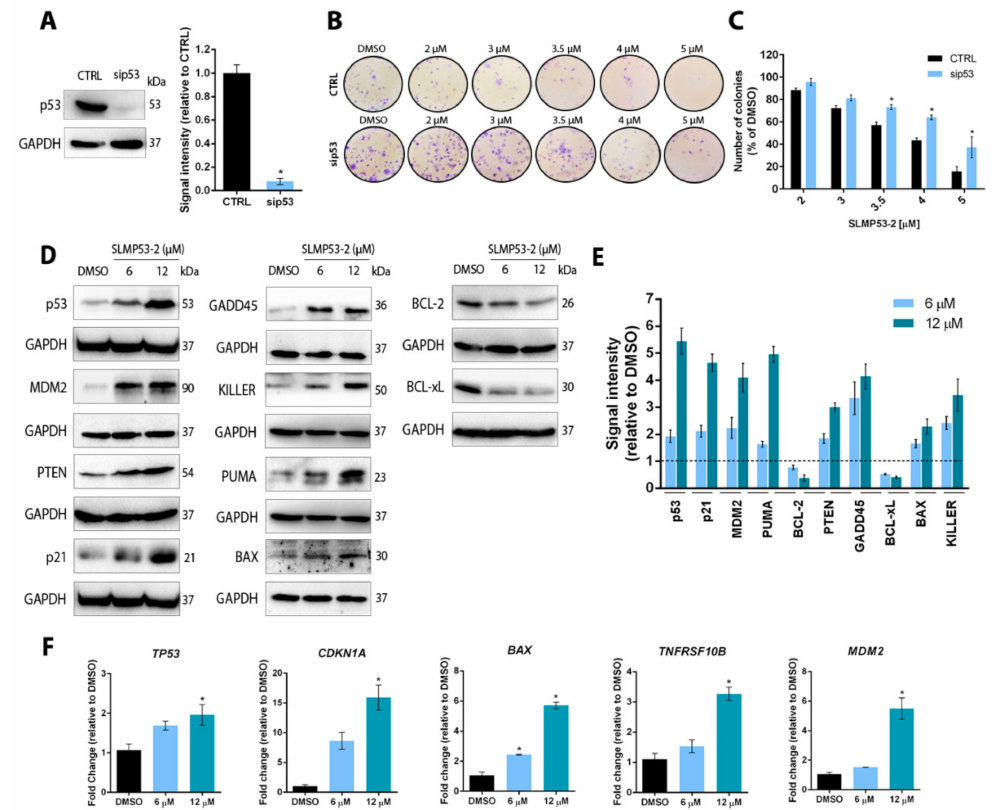
Figure 2. SLMP53-2 has p53-dependent growth inhibitory effect in melanoma cells with enhancement of p53 transcriptional activity. ( A – C ) Colony formation assay for silenced p53 (sip53) and control (CTRL) A375 cells treated with SLMP53-2, allowed to grow for 11 days. In ( A ), silencing efficacy of p53 by siRNA is shown; immunoblots are representative of five independent experiments and GAPDH was used as loading control; data plotted were normalized to CTRL and correspond to mean ± SEM, n = 5; values are significantly different from CTRL: * p < 0.05, unpaired Student’s t -test. In ( B ), images are representative of five independent experiments. In ( C ), data are normalized to DMSO and correspond to mean ± SEM, n = 5; values of sip53 cells significantly different from CTRL cells: * p < 0.05, two-way ANOVA followed by Sidak’s